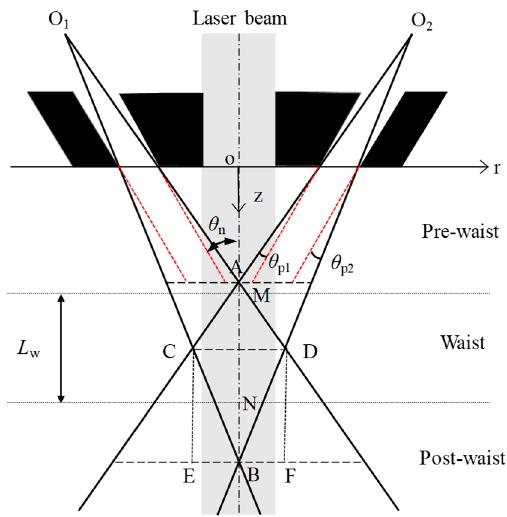
Figure 1. Schematic diagram of half of the coaxial nozzle structure.